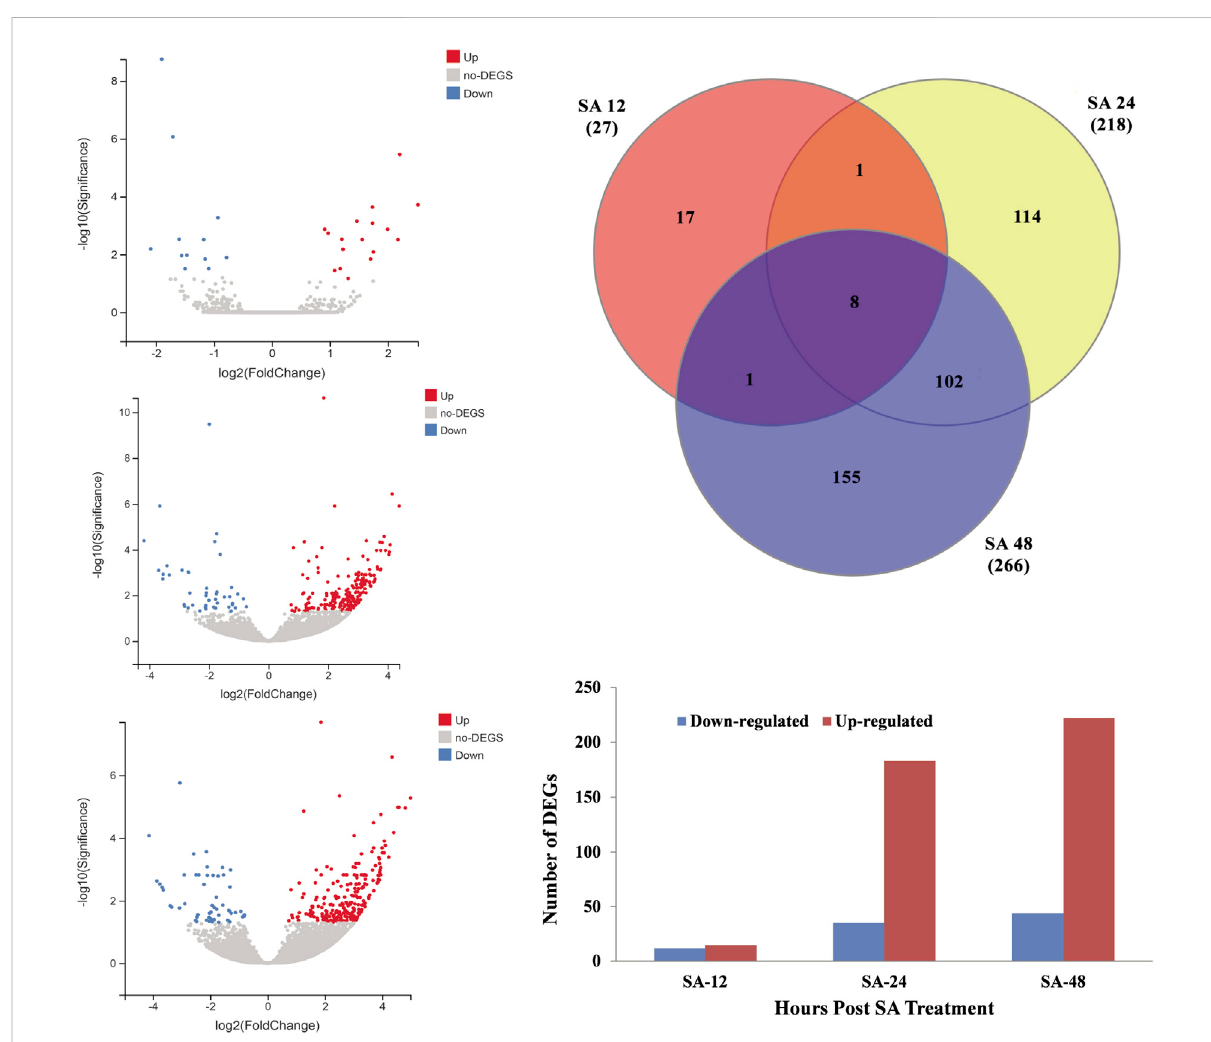
FIGURE 3 Distribution of DEGs from RNA-seq data. (A) Volcano graph of DEGs representing the downregulated genes with blue color and upregulated DEGs with red color after 12 h of SA treatment. (B) Volcano graph of DEGs representing the downregulated genes with blue color and upregulated DEGs with red color after 24 h of SA treatment. (C) Volcano graph of DEGs representing the downregulated genes with blue color and upregulated DEGs with red color after 48 h ofSA treatment. (D) Venn diagram analysis of DEGs identi fi edfrom all time points. (E) Total number of DEGs that were signi fi cantly down- or upregulated in response to SA treatment. Log2 FC ≥ 1 or ≤ − 1 and p < 0.01